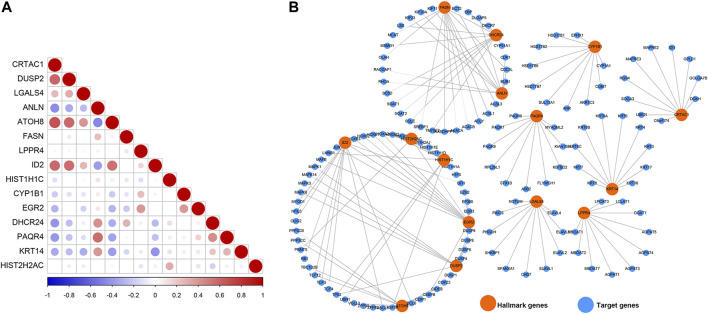
Co-expression relationship and protein-protein interaction network. (A) The correlation diagrams show the correlation among 15 prognosis-related genes for MIBC. The positive correlations are colored by red, and negative correlations are colored by blue. The size of the point represents the p-value. (B) The PPI network diagram shows the proteins that have potential interactions with 15 prognosis-related genes.